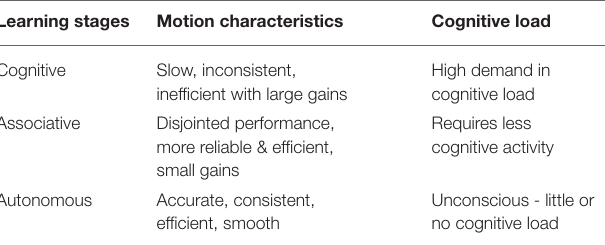
TABLE 2 | Human motor learning stages and their motion and cognitive load characteristics. Learning